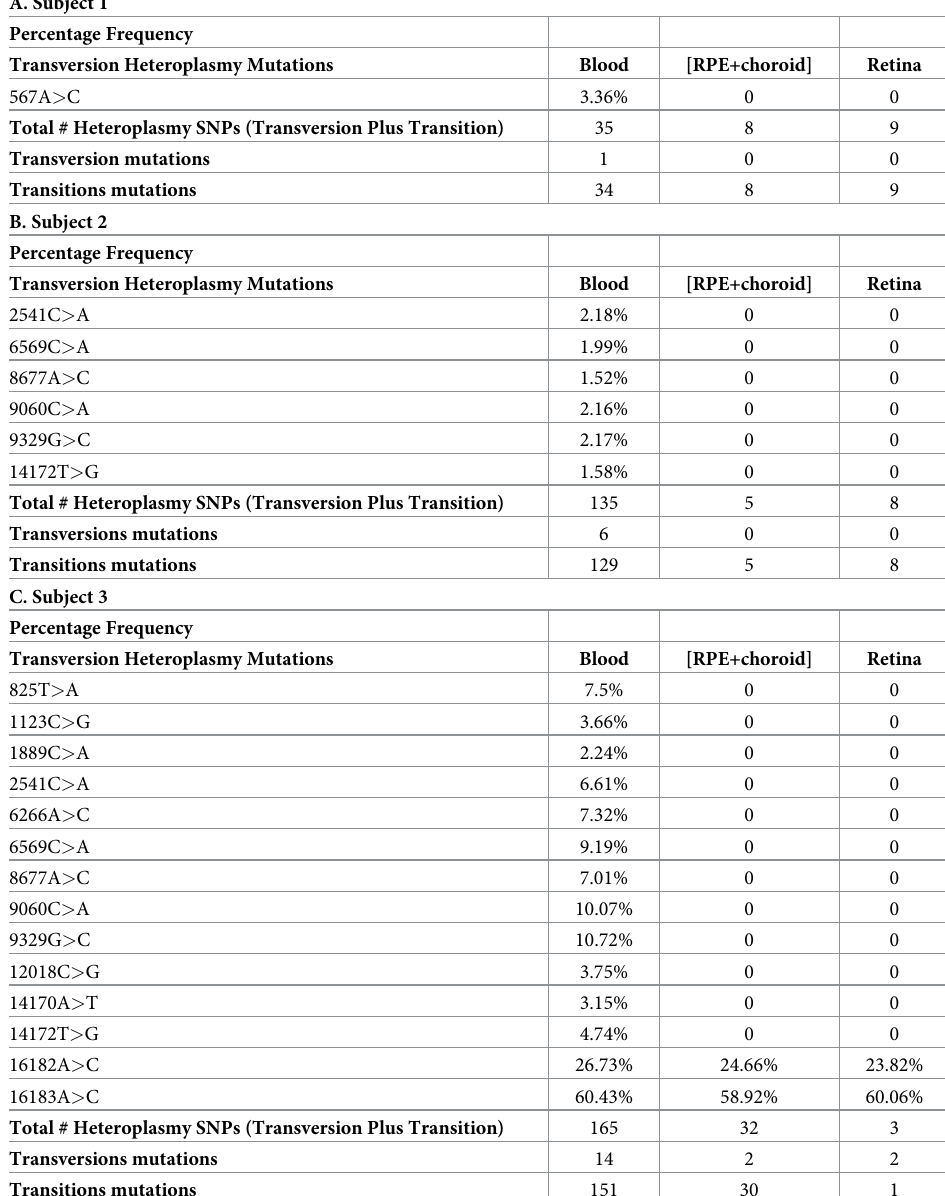
Table 10. Transversion versus transition mutations in mtDNA of each